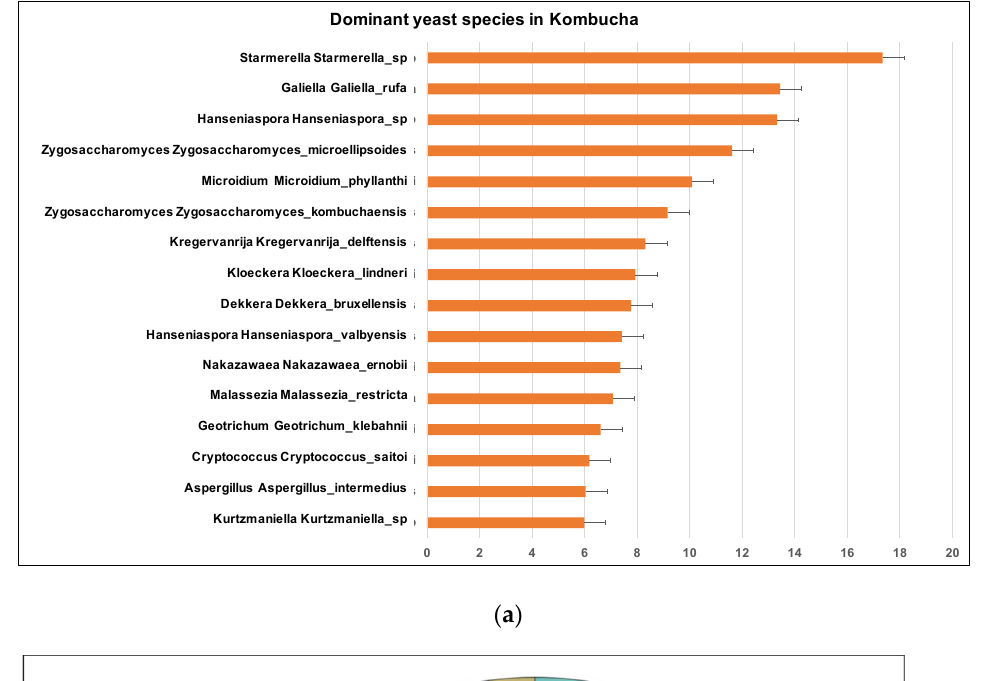
Figure 5. Abundance of yeast species each dominant genus has in kombucha. On average, genus Cryptococcus , Han- seniaspora , Penicillium and Vishniacozyma show three different species across kombucha samples.